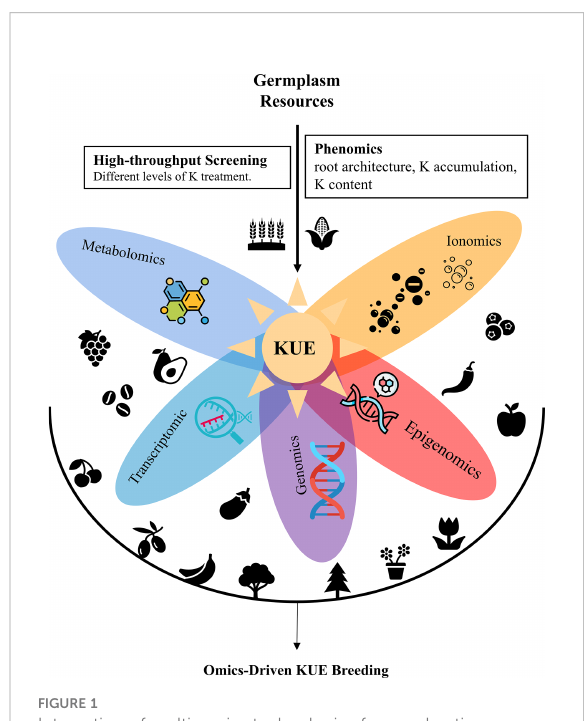
FIGURE 1 Integration of multi-omics technologies for accelerating crop KUE